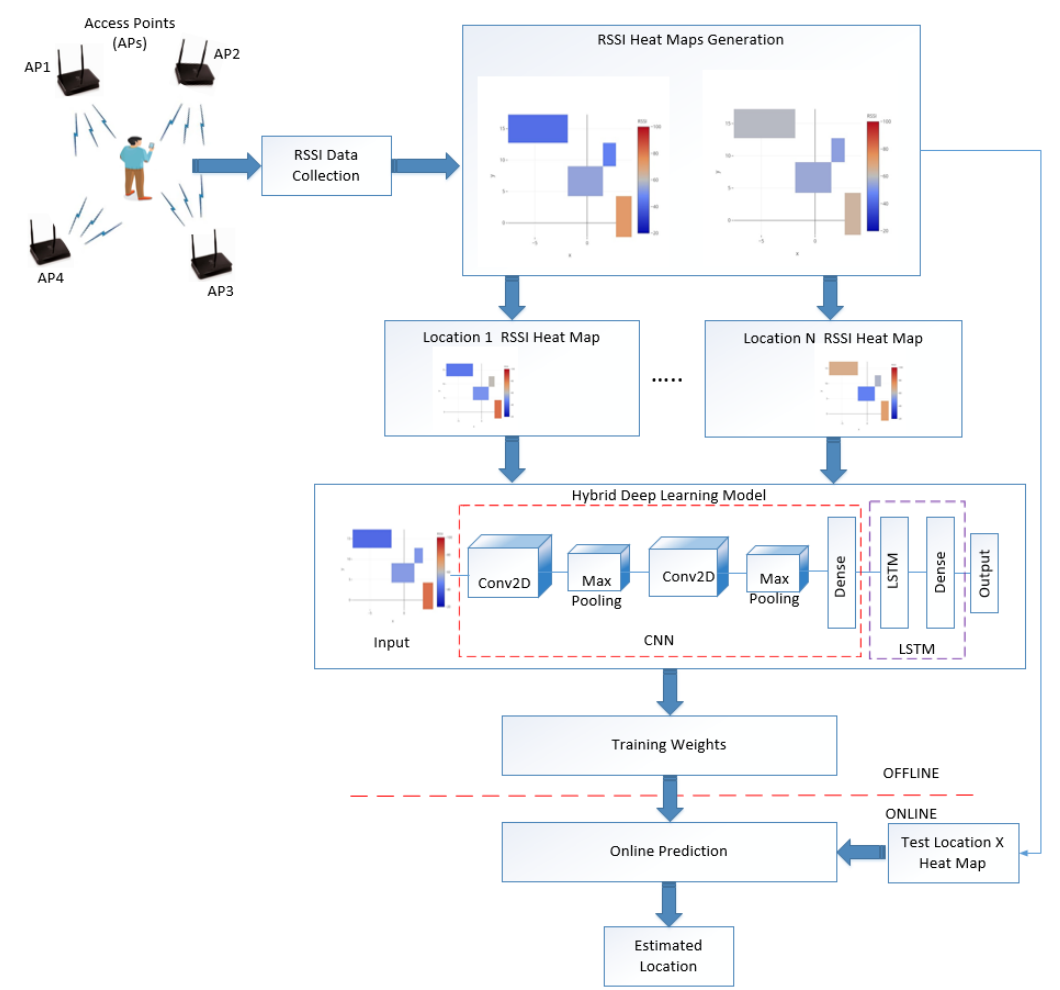
Figure 1. Proposed hybrid deep learning model based indoor positioning